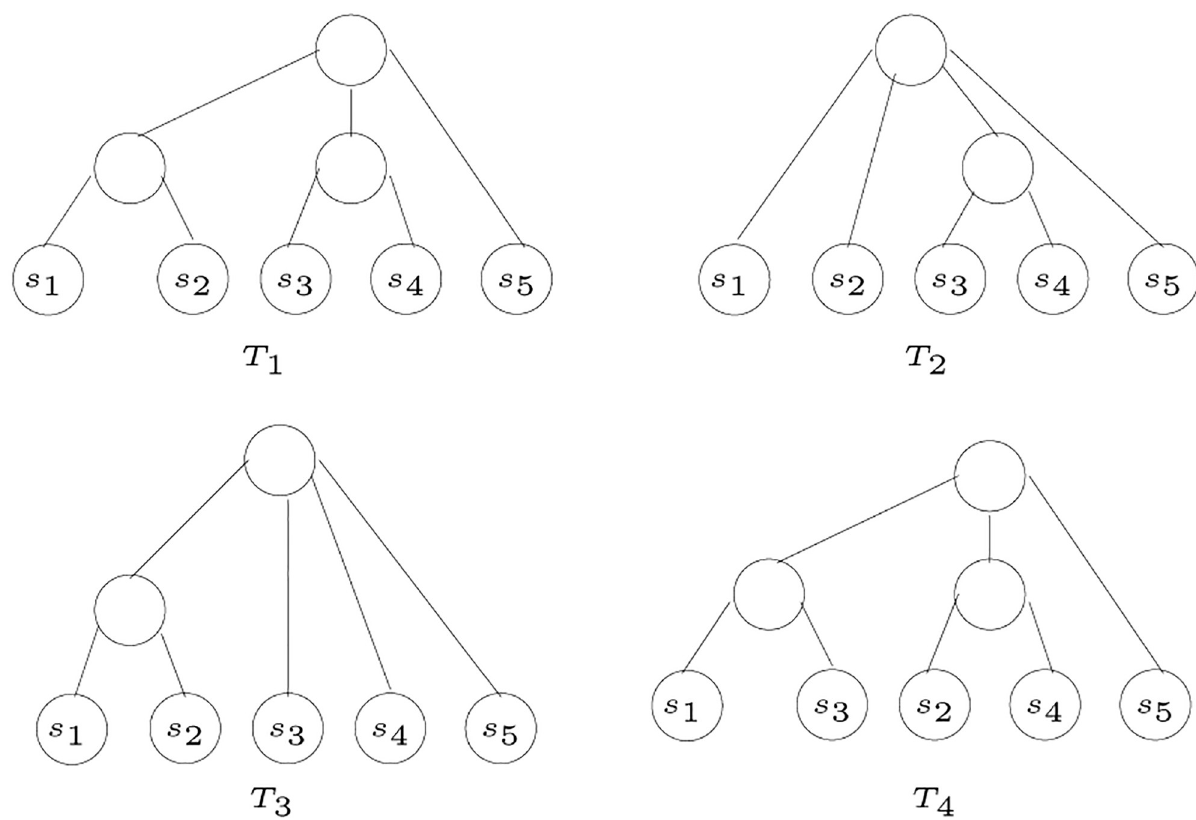
Fig 34. An example to illustrate the algorithm